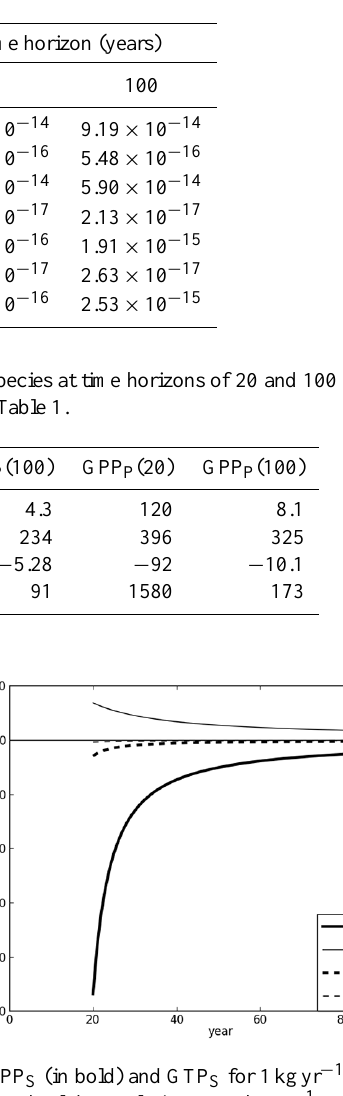
Table 1. Absolute metrics, AGWP, AGTP P , AGTP S , AGPP P and AGPP S for CO 2 at time horizons of 20 and 10 years, which are chosen for illustrative purposes. The first and second sets of AGPP values use the CO 2 f factor from Andrews et al. (2010) and Kvalevåg et al. (2013), respectively (see Table A1).